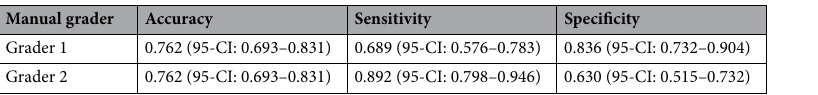
Table 3. Manual grading on the training dataset. CI confidence interval.